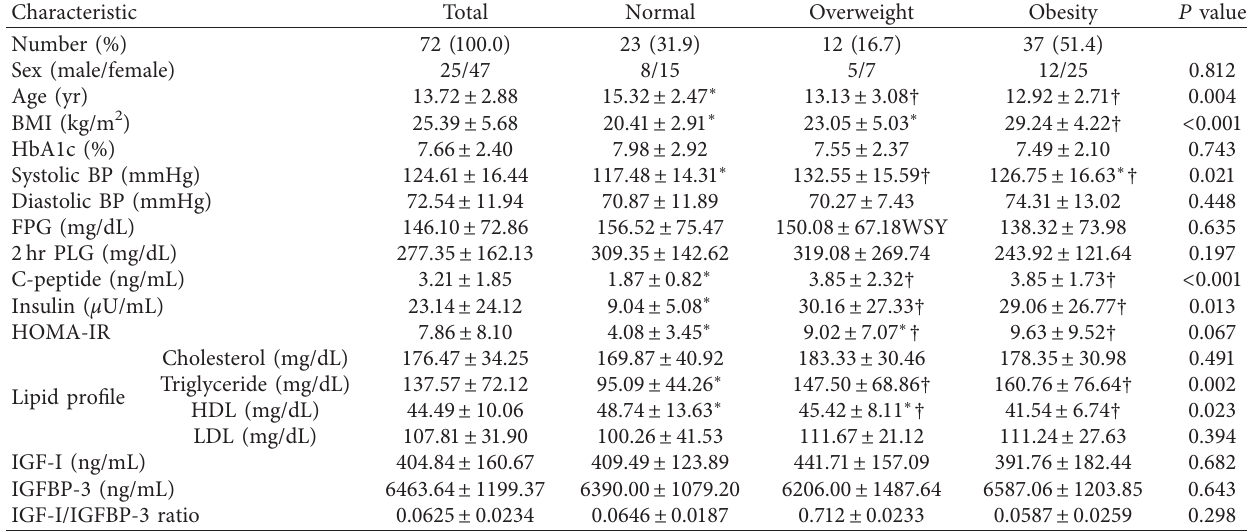
Table 3: Clinical characteristics of the study subjects with glucose intolerance according to BMI.